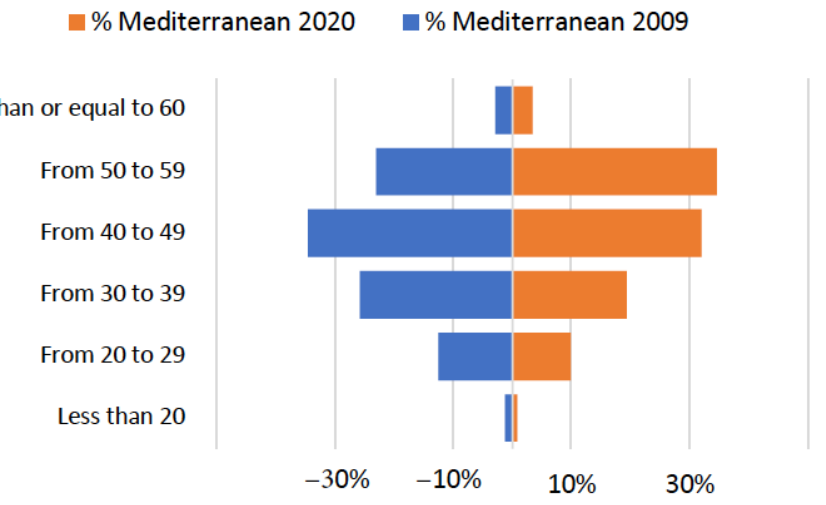
Figure 7. Comparison of the population pyramid of workers affiliated to the REM in the Spanish Mediterranean in 2009 and 2020 10